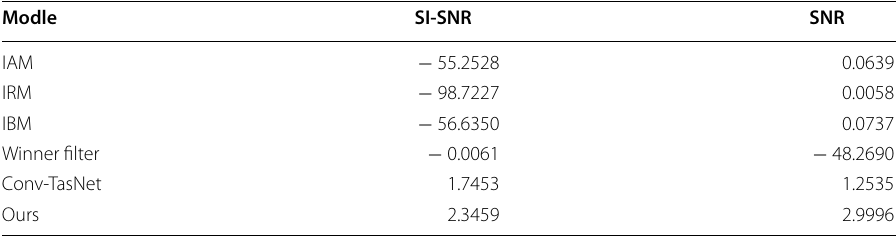
Table 1 Objective evaluation